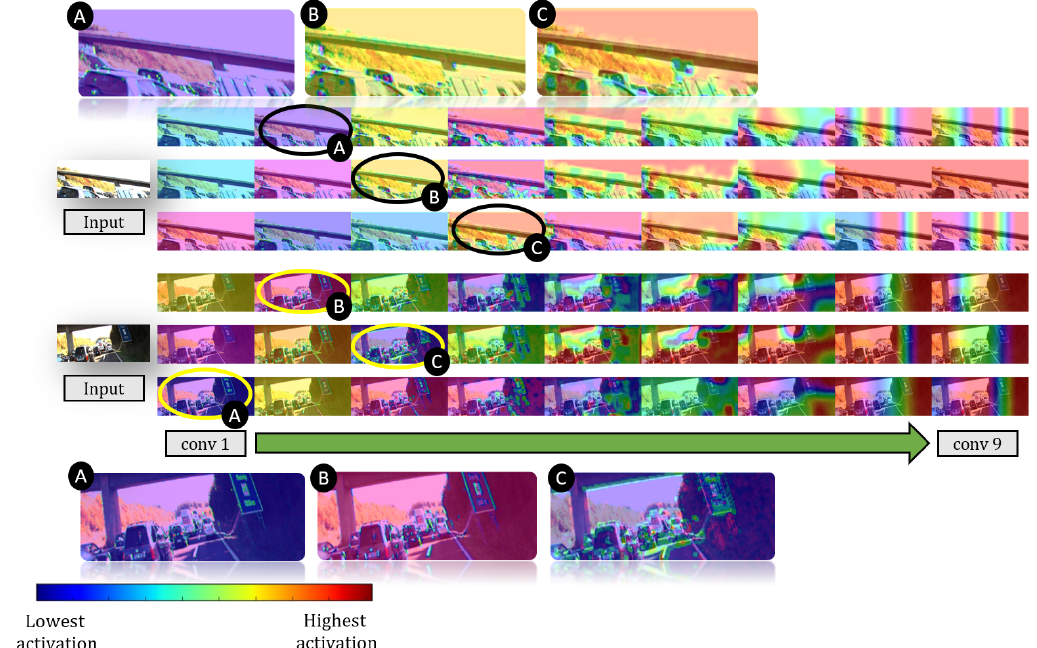
Figure 12. Gradient-weight activation maps for each convolutional layer. Each row represents the networks N ( { m 3,1 , m 3,2 } ) , N ( { m 1,1 , m 2,2 } ) and N ( { m 1,2 , m 2,1 } ) respectively. The networks tend to lean towards activation of edges and contours on the first four layers while the remaining layers focus on specific regions. Thumbnails encircled have their zoomed version shown to highlight the activations on earlier layers.